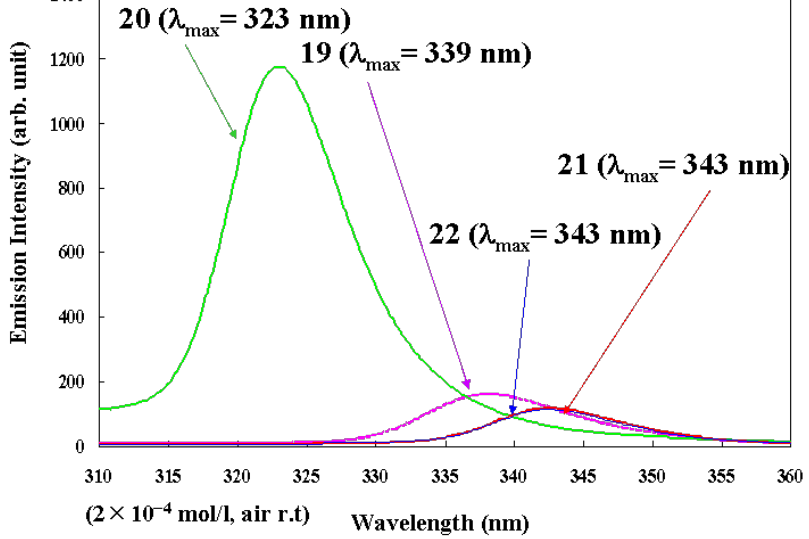
), measured maximum wavelength in cal ), energy difference between the 5 D level of exp 4 (eV)), and intensity cal